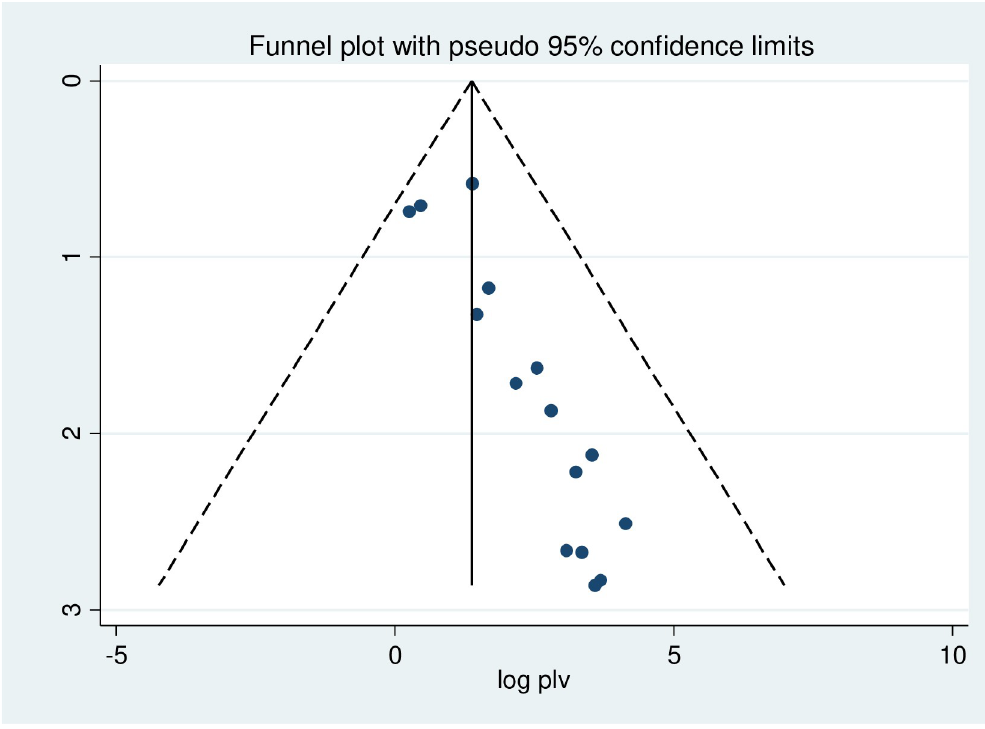
Fig 4. Funnel plot to test the publication bias in 15 studies with 95% confidence limits.